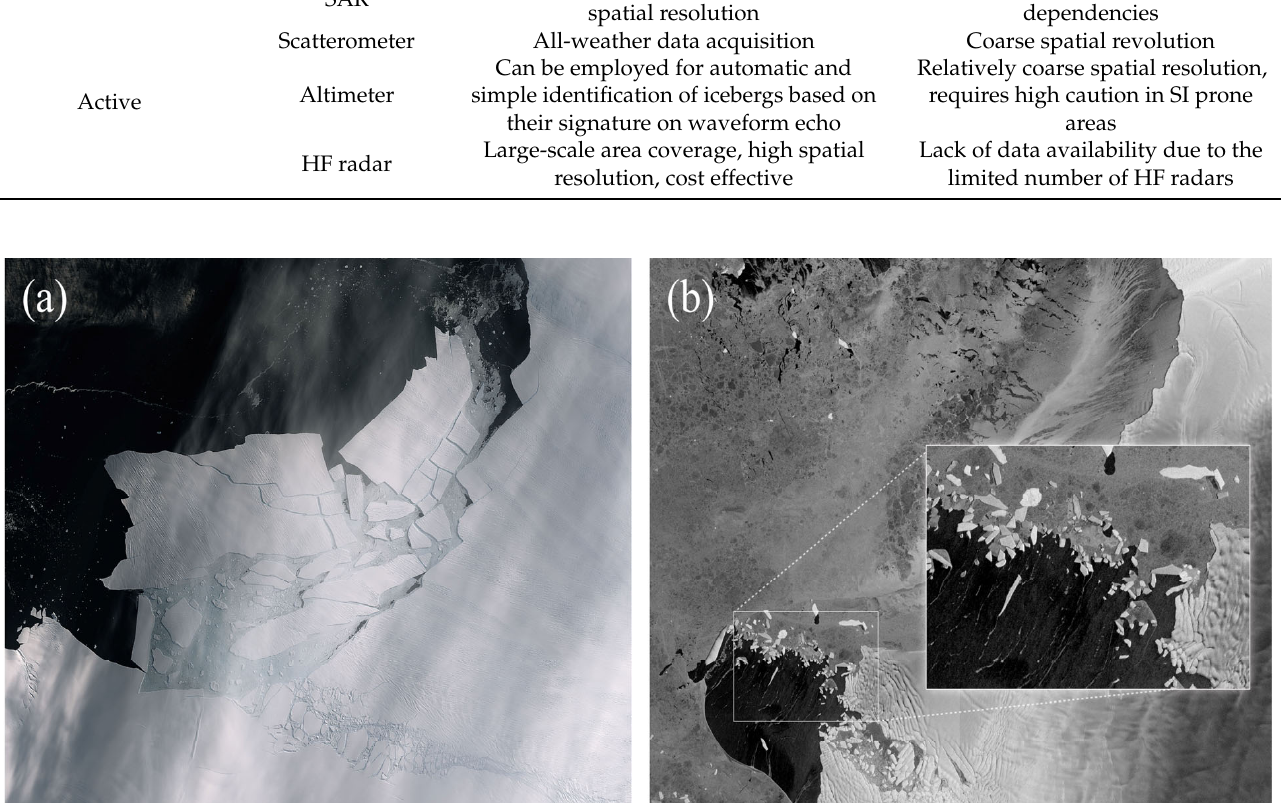
Figure 2. An example of iceberg in satellite imagery: ( a ) A 300 square kilometer iceberg spawned from the Pine Island Glacier captured by the Sentinel-2 optical image (ESA, n.d.), and ( b ) Sentinel-1 SAR data acquired over parts of the Pine Island Glacier and Thwaite Glacier (ESA, n.d.).